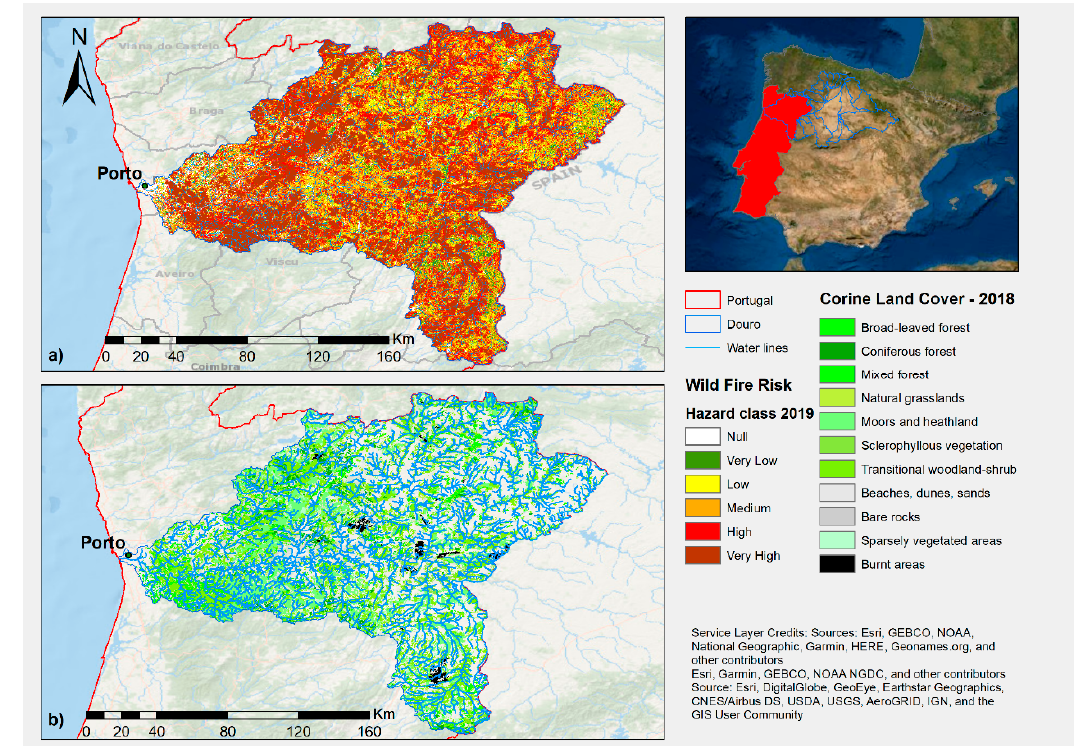
Figure 1. Location map illustrating the Douro River Basin and emphasizing the Portuguese side. In evidence is the wildfire risk map of 2019 ( a ) and the land use, more precisely the Forest and semi-natural areas from Corine Land Cover—2018 ( b ).